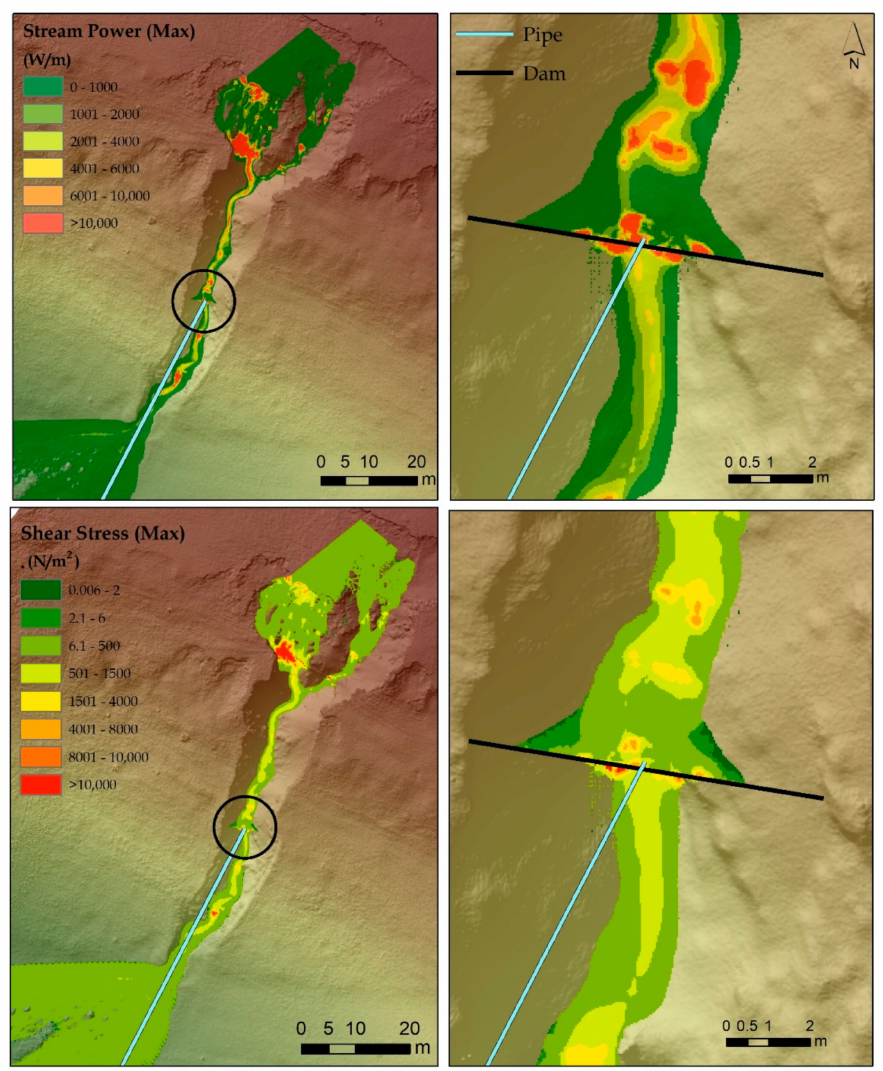
Figure 15. Results of simulation